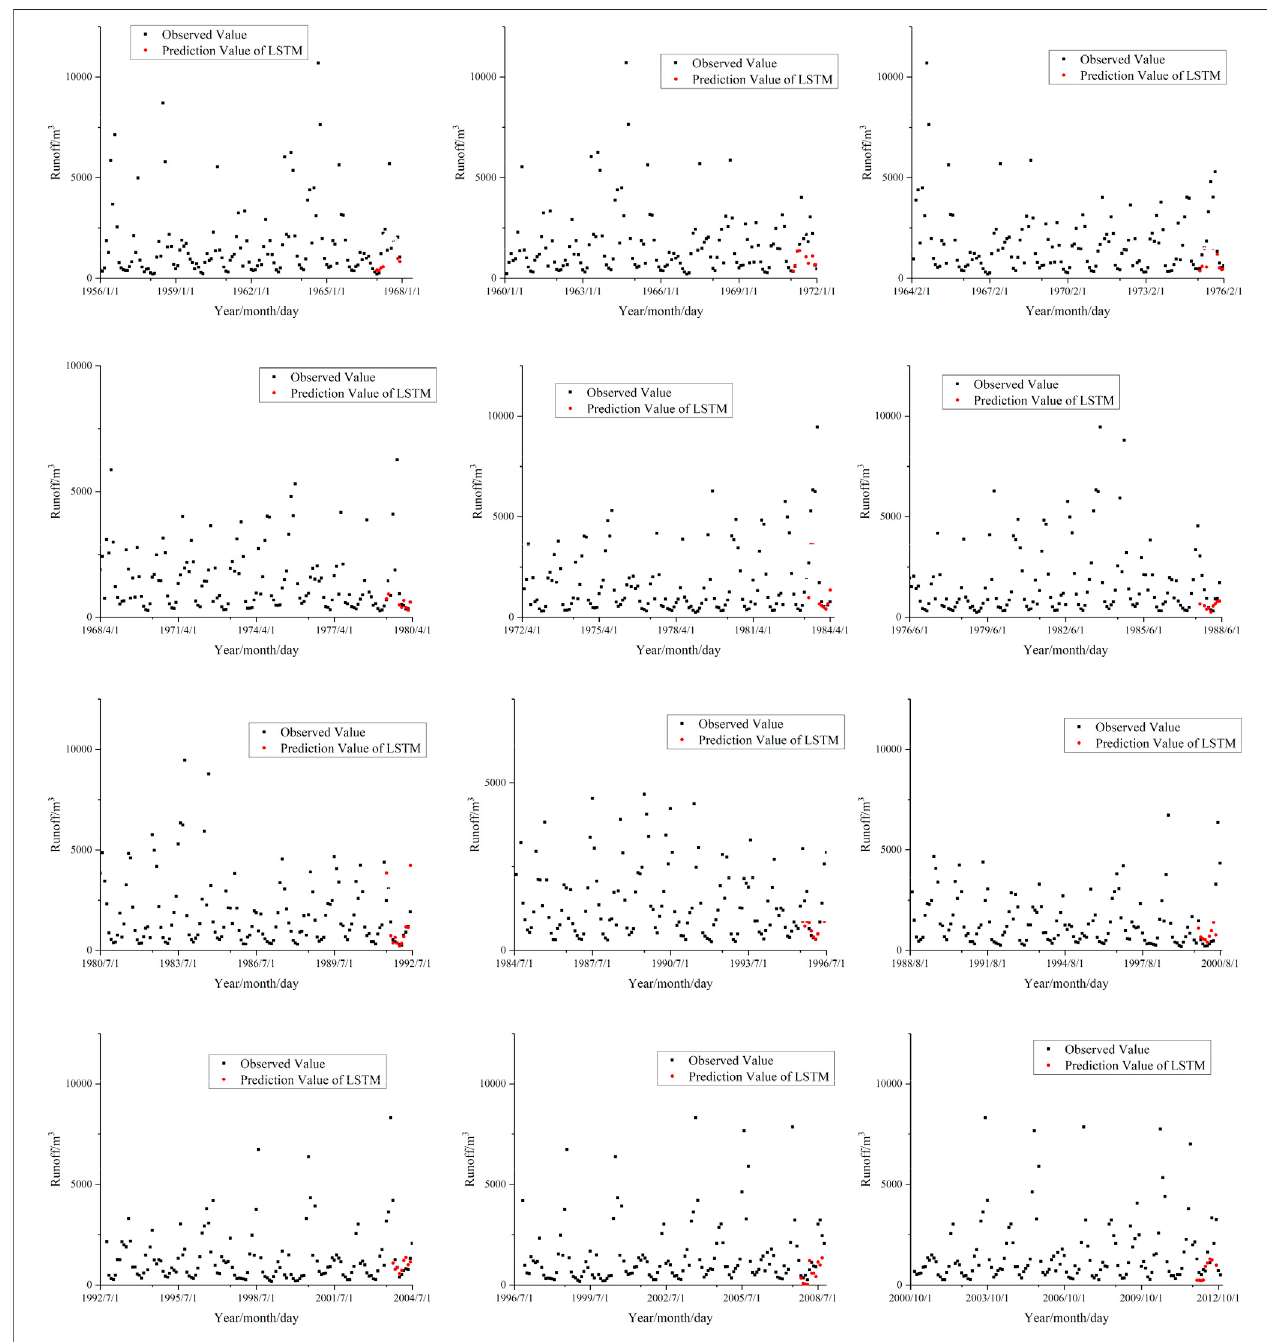
FIGURE 4 | The results of cross-validation based on the